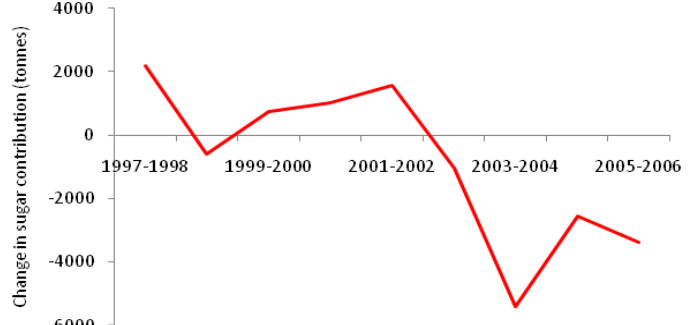
Figure 6. Annual change in contribution of nutritively-sweetened carbonated soft drinks to total added sugar in the Australian food supply